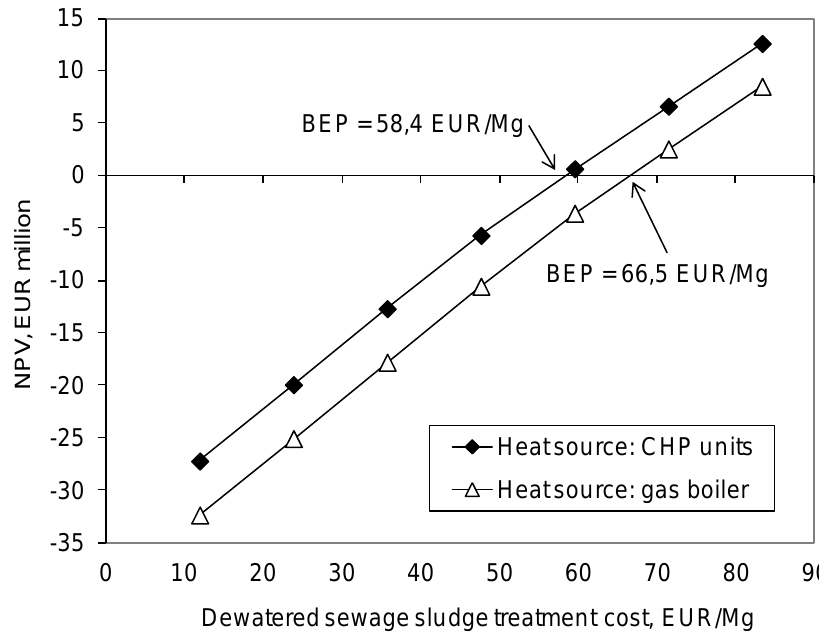
Figure 12. NPV(15) index in function of the dewatering sludge treatment cost (Cases 1 and 14).